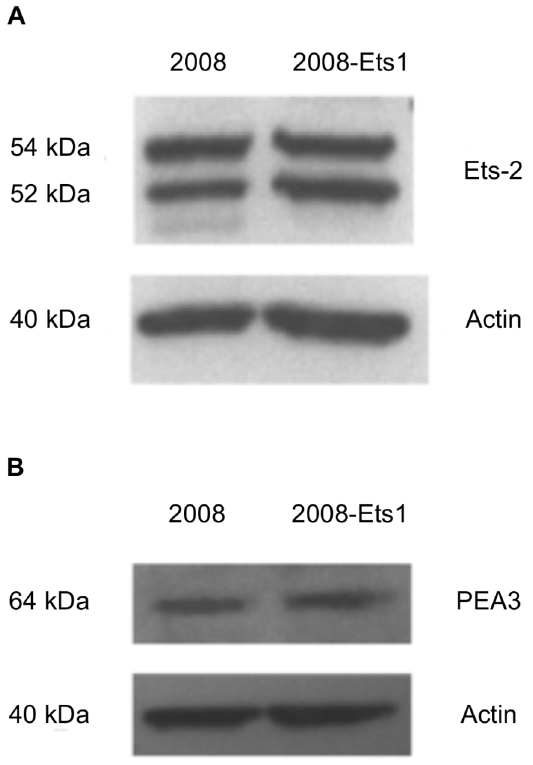
Figure 2. Ets-1 expression did not affect the expression of similar ETS family members. The protein expression of ETS family transcription factors ( A ) Ets-2 and ( B ) PEA3 were compared in 2008 and 2008-Ets1 ovarian cancer cells to determine the specificity of our Ets-1 expression model. Western blot analysis showed that neither of these transcription factors was affected by Ets-1 expression in 2008 cells.